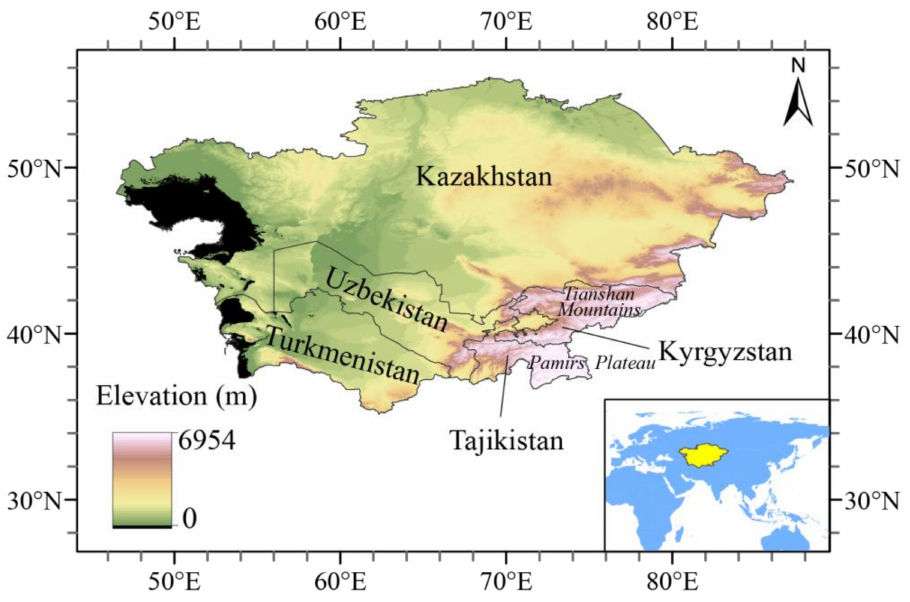
Figure 1. Country distribution and elevation of Central